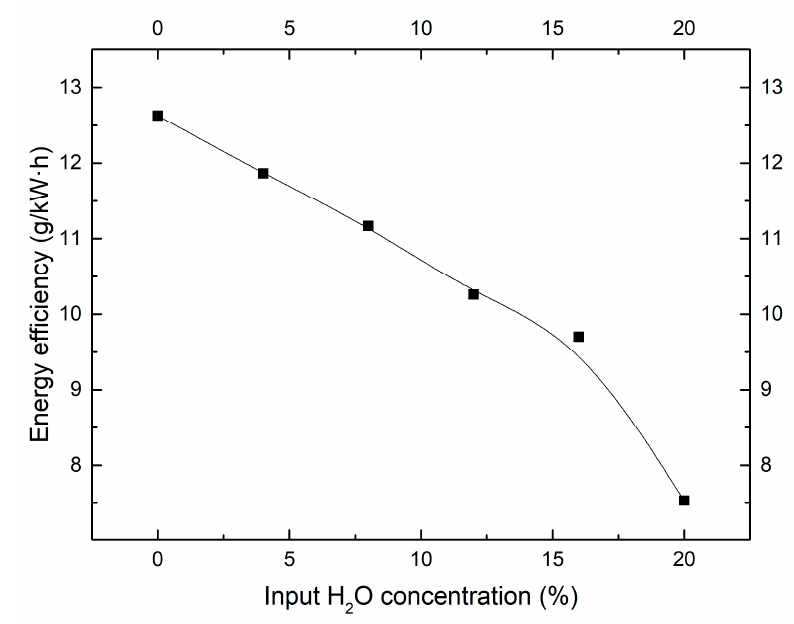
Figure 6. Effect of moisture concentration on energy efficiency.